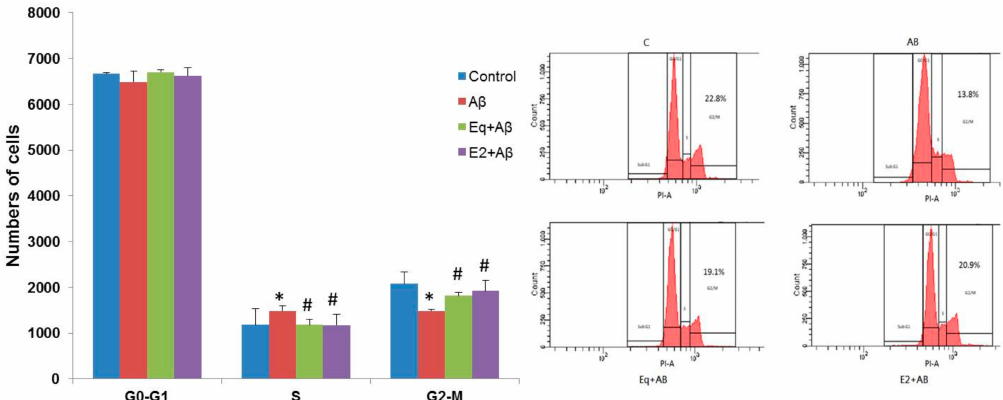
Figure 4. Cell cycle events of SH-SH5Y cells from di ff erent treatments. The cell cycle was assessed by PI staining with flow cytometry. Data were analyzed by one-way ANOVA followed by the LSD post-hoc test and are representative of three independent experiments ( n = 3). Values are presented as the mean + SD. * p < 0.05 vs. the control; # p < 0.05 vs. the A β